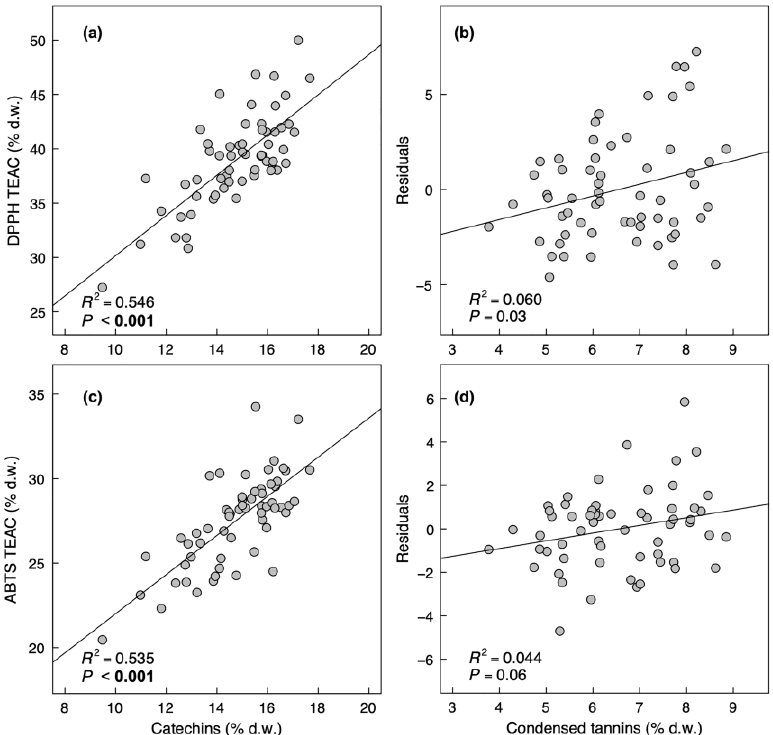
Figure 3. Regression analyses of catechins as a contributor to TEAC in ( a ) DPPH (2,2-diphenyl-1- picrylhydrazyl) and ( c ) ABTS (2,2′ -azinobis-(3-ethylbenzothiazoline-6-sulfonic acid) radical scav- enging assays, ( b ) residuals from ( a ) vs. condensed tannins, ( d ) residuals from ( c ) vs. condensed tannins. Each point represents the value for a single plot replication within each of the 20 tea cultivars. % d.w. = % foliar dry weight. Table 2. Partial least squares regression analyses examining the influence of main catechin compo- nents on the antioxidant capacity within tea leaves across 20 tea cultivars (n = 60). Model fitting parameters indicate the strength of relationships between explanatory and response variables. An- tioxidant capacity is represented as TEAC (Trolox equivalent antioxidant capacity) in DPPH (2,2- diphenyl-1-picrylhydrazyl) and ABTS ( The 2,2′ -azinobis-(3-ethylbenzothiazoline-6-sulfonic acid)) radical scavenging assays. C, catechin; EC, epicatechin; ECG, epicatechin gallate; EGC, epigallocat- echin; EGCG, epigallocatechin gallate.